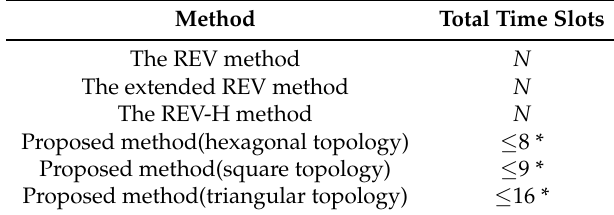
Figure 14. Simulation results of total time slots used for arrays with different number of antennas and different topologies. Table 5. Comparison of time slots used among different methods, where N is the total number of antennas.